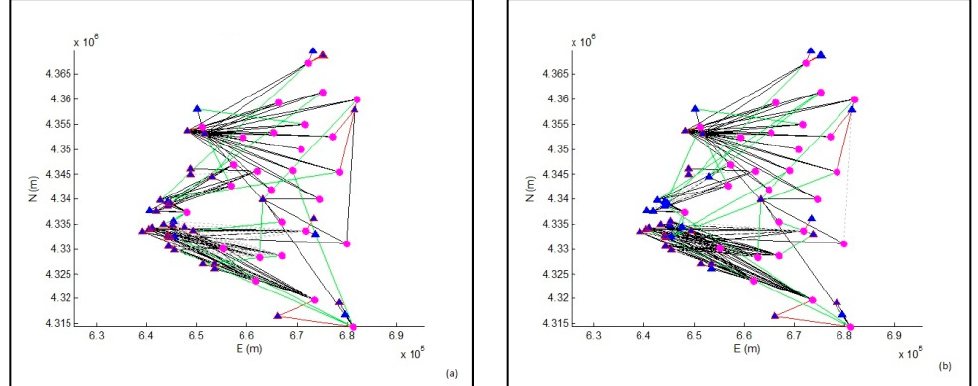
Figure 6. Output of the model for the two scenarios considered. On the left ( a ), links between source nodes and destination nodes with reference to the current availability; on the right ( b ), links between source nodes and destination nodes with reference to the future climate change scenario. Green lines indicate new connections; blue triangles represent source nodes whose water is completely distributed to users; blue triangles with red borders indicate source nodes which are also connected with the dummy destination (source node with a surplus of water that remains at the source node itself); magenta circles represent the destination nodes; black solid lines represent pre-existing connections; dotted gray lines represent deleted links; red lines represent existing links with pump stations.